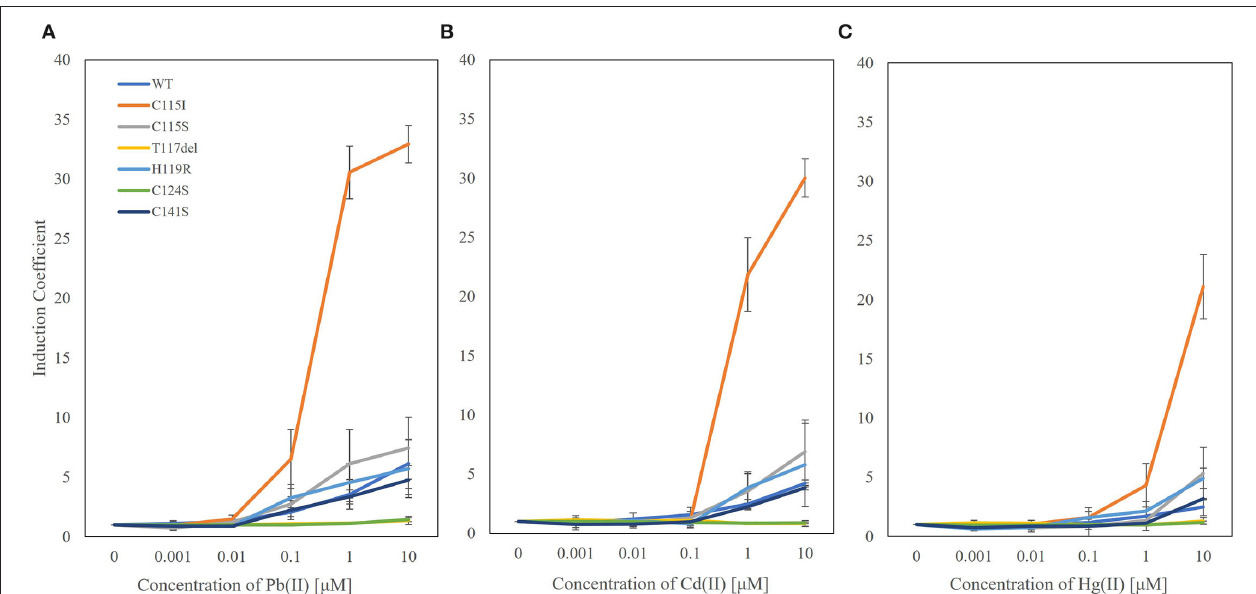
FIGURE 3 | The metal specificity of biosensors based on E. coli-zntR/copA/zntA harboring pZnt-eGFP and ZntRs toward lead (A) cadmium (B) and mercury (C) . The biosensors were exposed to 0 to 10 µ M ranges of metal ions and determined the induction coefficient values after 2h exposures.